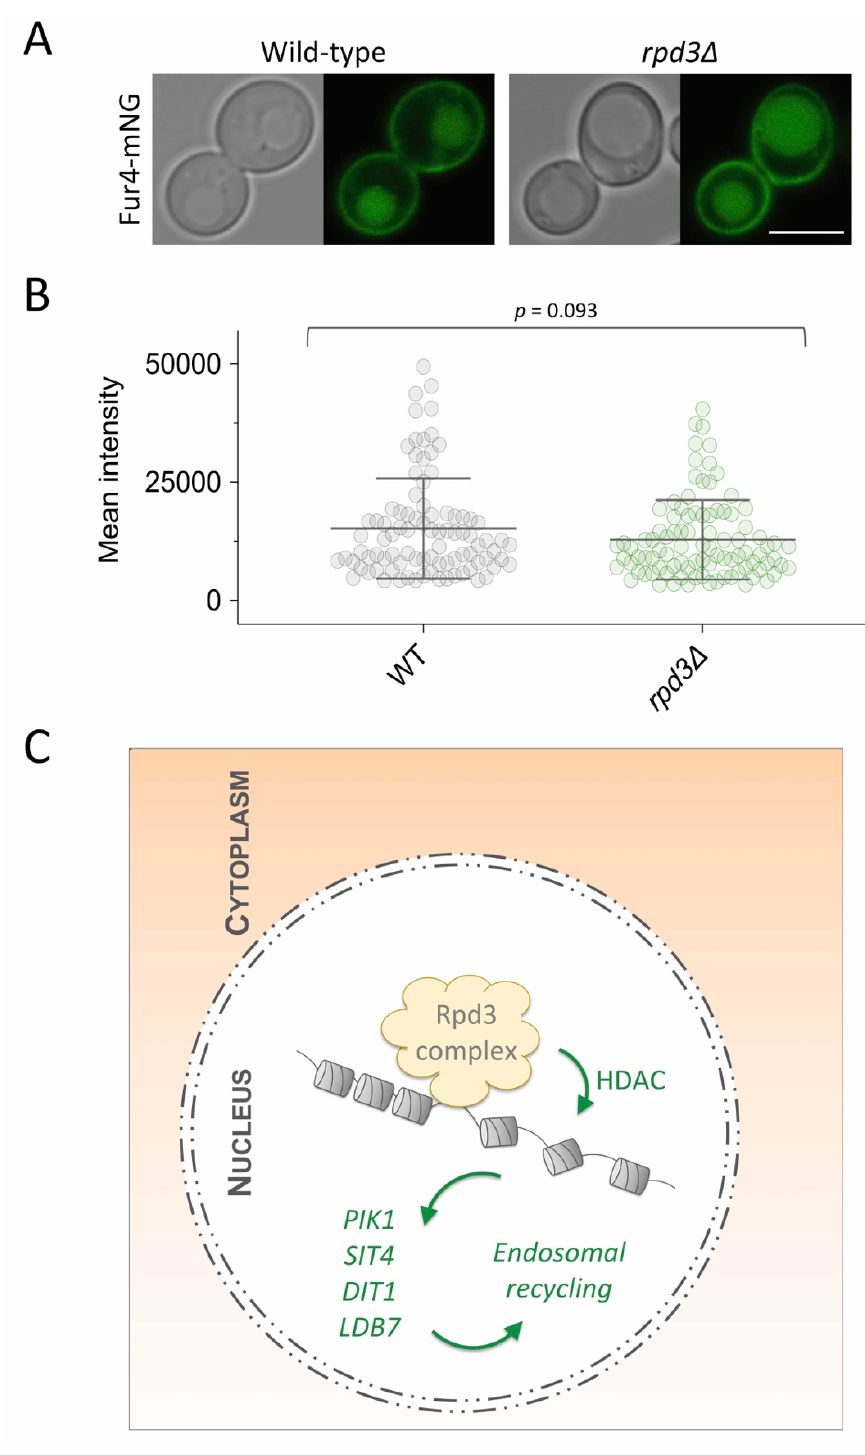
Figure 8. Summary model: ( A ) Wild-type and rpd3 ∆ cells expressing Fur4-mNeonGreen (Fur4-mNG) from a plasmid were grown to mid-log phase, resuspended in azide-containing buffer and then imaged using confocal fluorescence microscopy. ( B ) Micrographs from ( A ) were segmented based on DIC images and then the GFP fluorescence signal measured for each wild-type ( n = 93) and rpd3 ∆ ( n = 94) cells, then mean intensity was plotted. ( C ) The Rpd3 chromatin remodelling complex localises to the nucleus and post-translationally deacetylates histones (HDAC activity) to control expression of PIK1 , SIT4 , LDB7 and DIT1 , which are all required for efficient cell surface recycling of internalised surface membrane proteins and lipids. Scale bar, 5 µm.